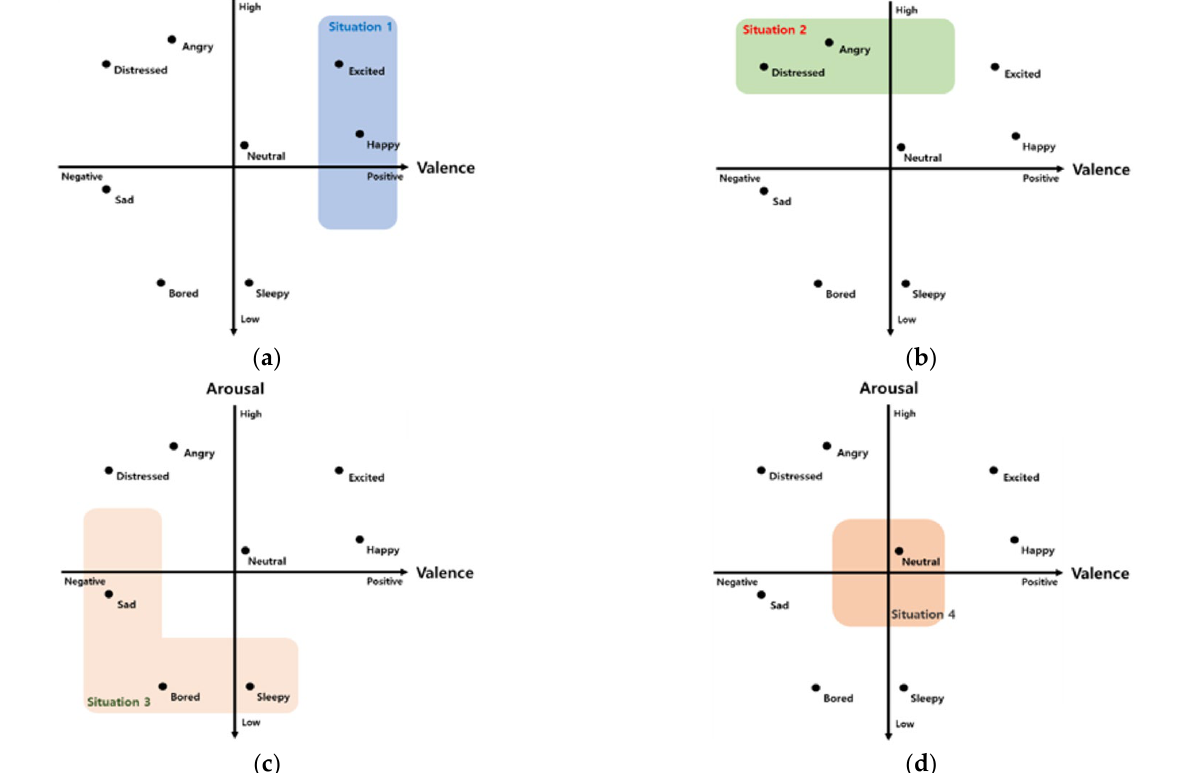
Figure 6. Two-dimensional arousal and valence domains by situation; ( a ) Speed perception ability; ( b ) Sudden situation recognition ability; ( c ) Driving situation judgment ability; ( d ) The ability to drive.